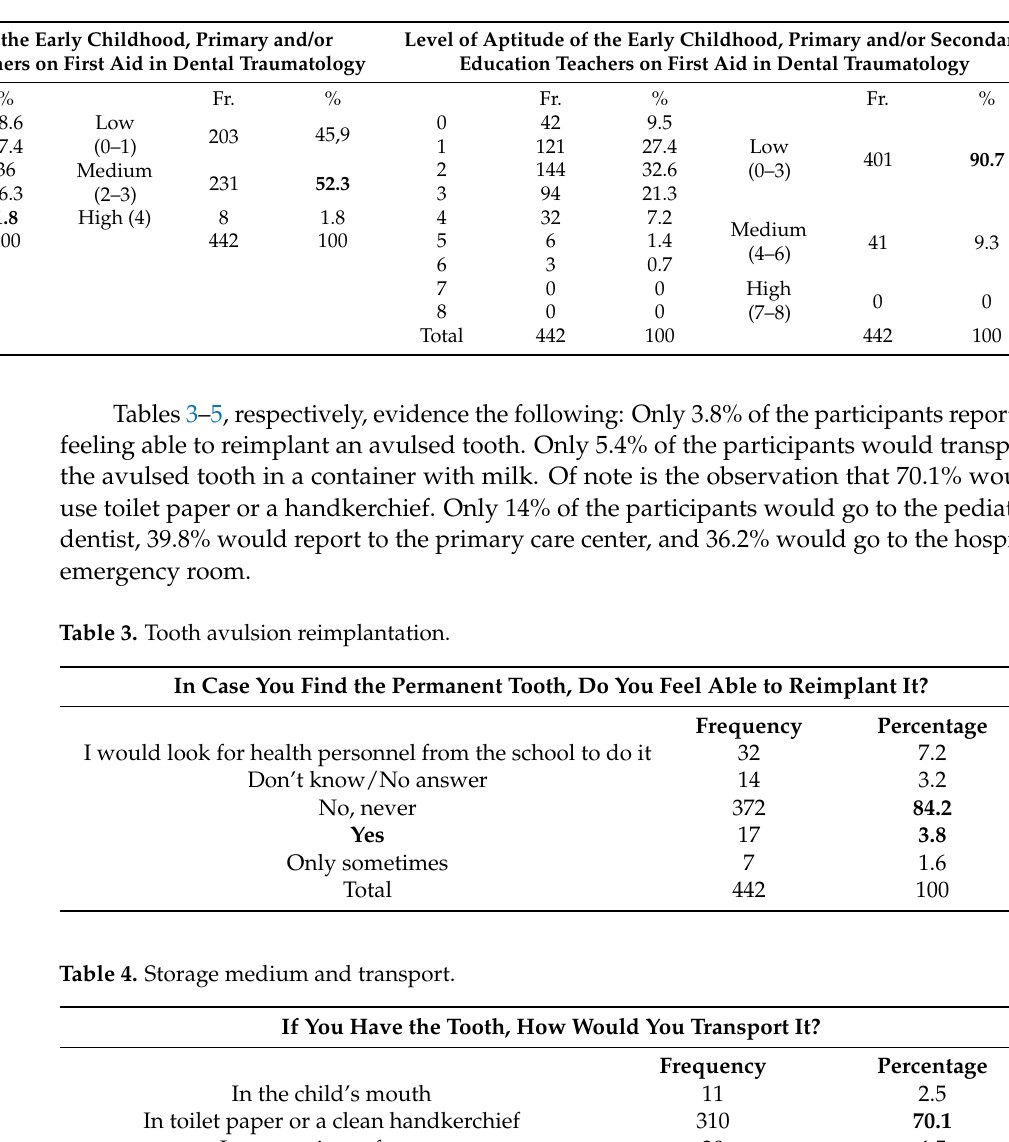
Table 2. Level of knowledge versus level of aptitude in relation to first aid measures in dental trauma.